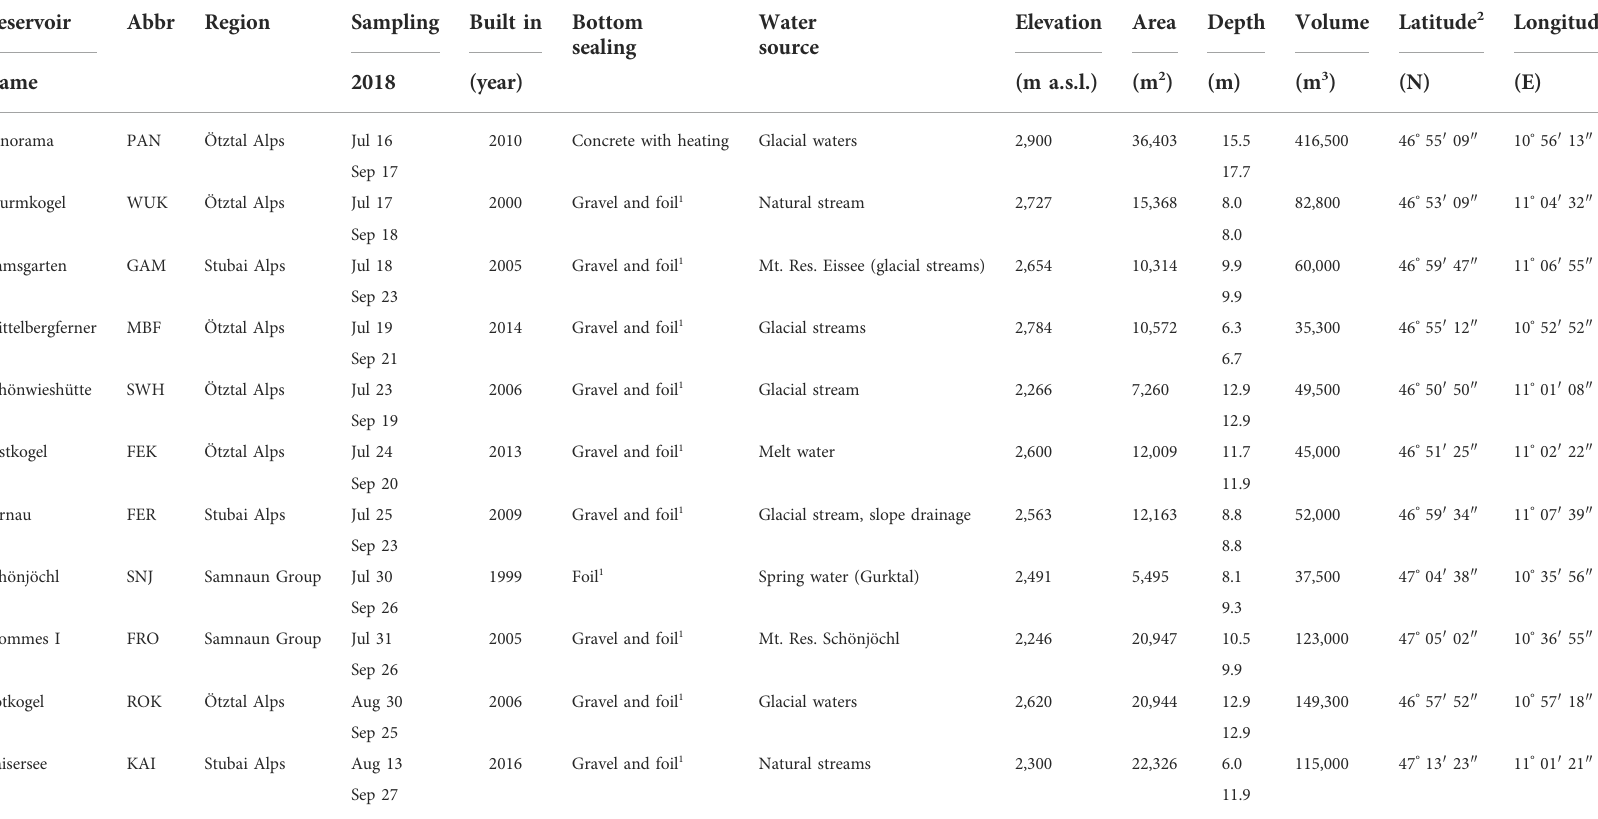
TABLE 1 Main characteristics of the mountain reservoirs including geographic region and coordinates, sampling date, year of construction, type of sealing, water source for fi lling, elevation, area, maximum depth on the day of sampling, and volume. Reservoir